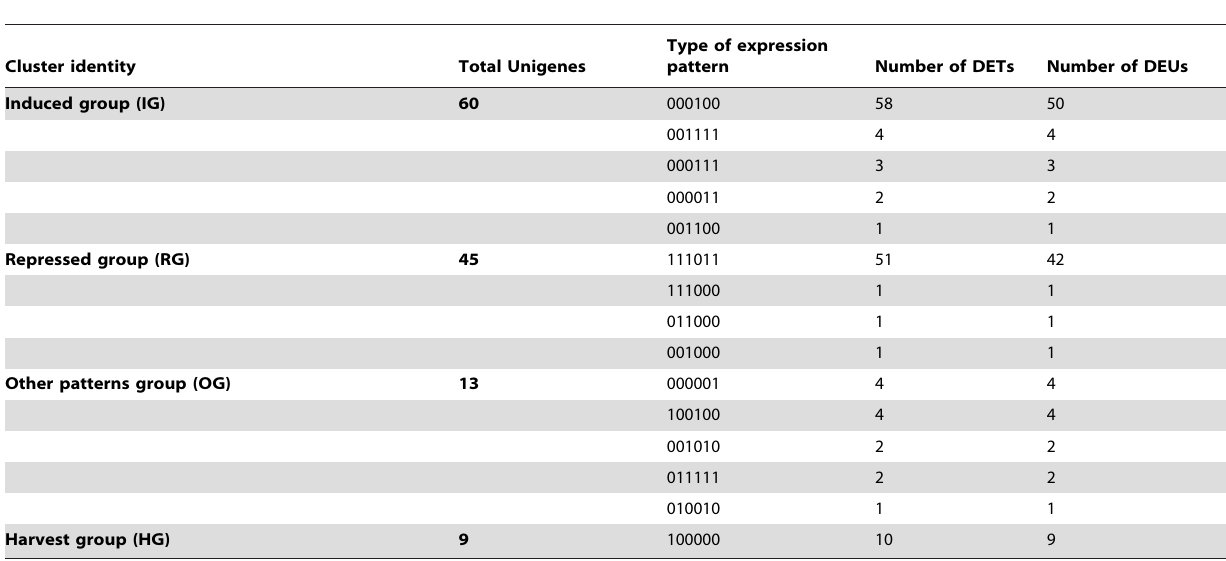
Table 1. Clustering of the identified differentially expressed transcripts (DETs) and summary of the total differentially expressed unigenes